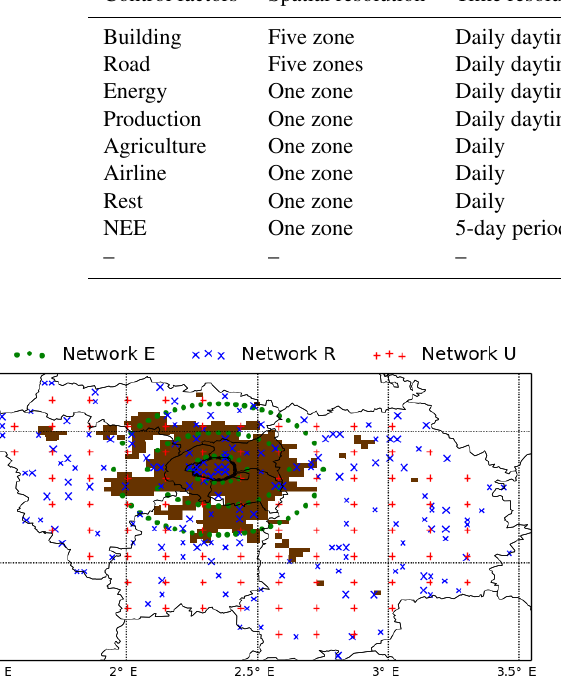
Figure 3. Locations for the elliptical (E), random-even (R), and uni- form (U) networks over IDF. The brown area marks out where the population density is larger than 1250 people perkm 2 . The E net- work (green dots) consists of three rings surrounding the densely populated urban area in brown. The U network (red crosses) ex- tends to the regular grid points of the IDF domain. The site locations of the R network are randomly selected, respectively, in three con- centric areas: (1) the city center (the administrative “city of Paris”) within the peripheral ring (coinciding with the smallest green ring), (2) the suburban area (in brown) with central Paris clipped out, and (3) the rest of